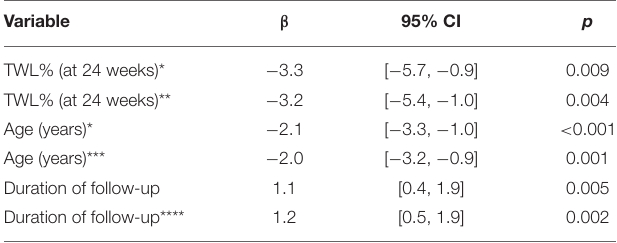
TABLE 2 | Analysis of Potential Predictors of Relative Weight Regain after Completion of the Milk-Based Meal Replacement Programme. Variable